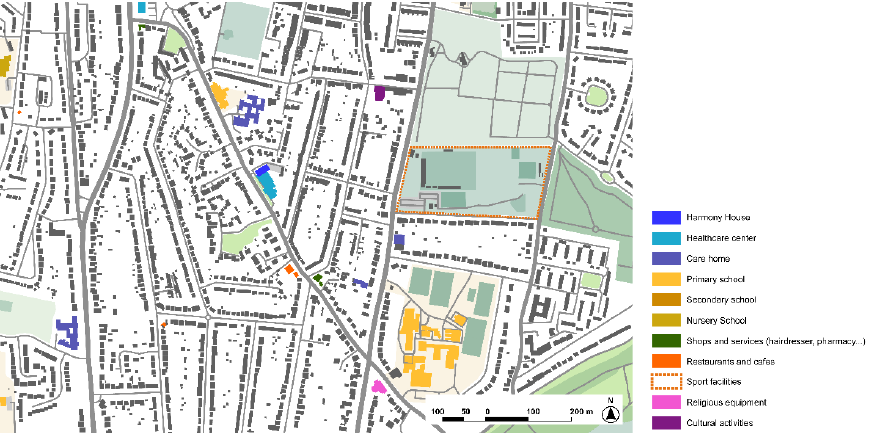
Figure 8. Site of the Harmony House under CASCADE project in Rochester, United Kingdom. Source: Own elaboration.